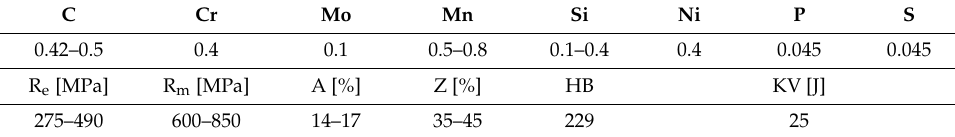
Table 1. The mechanical properties of C45 unalloyed steel and chemical composition in weight